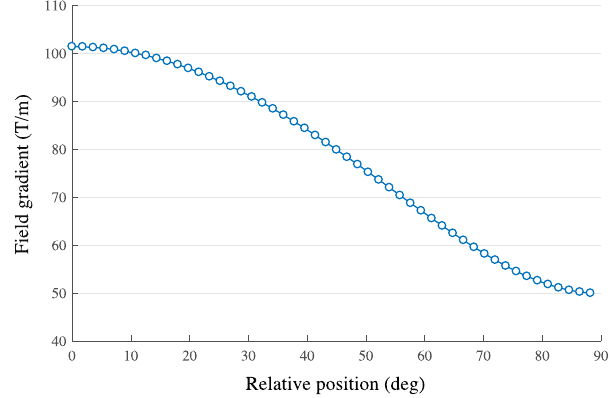
FIG. 15. Dependence of field gradient on relative angle between the two concentric rings.